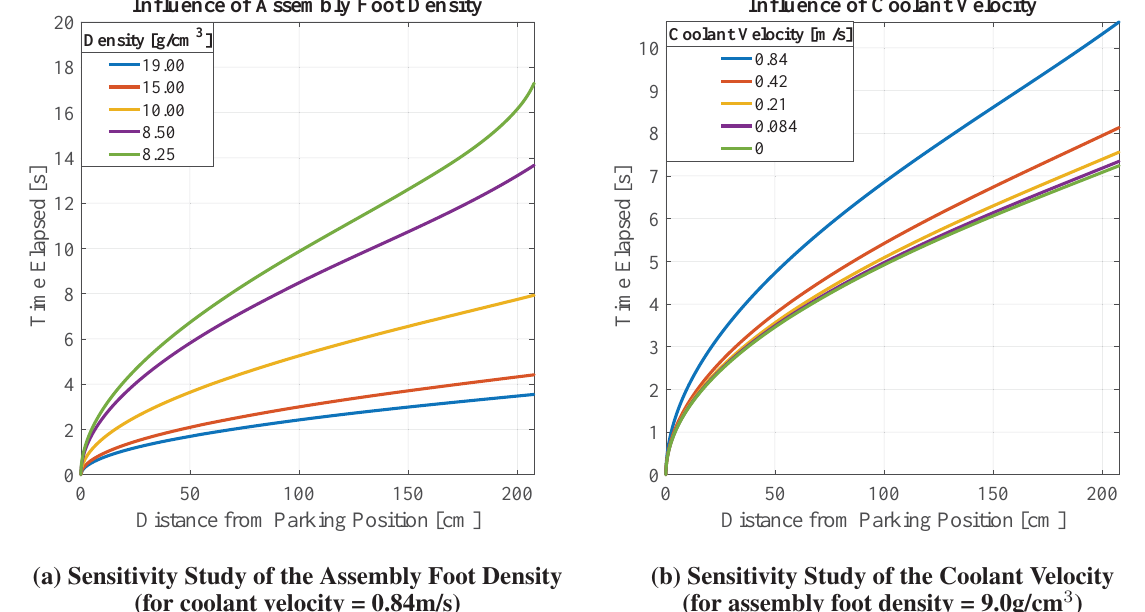
Figure 3: Influence of the Foot Density and the Coolant Velocity on Insertion